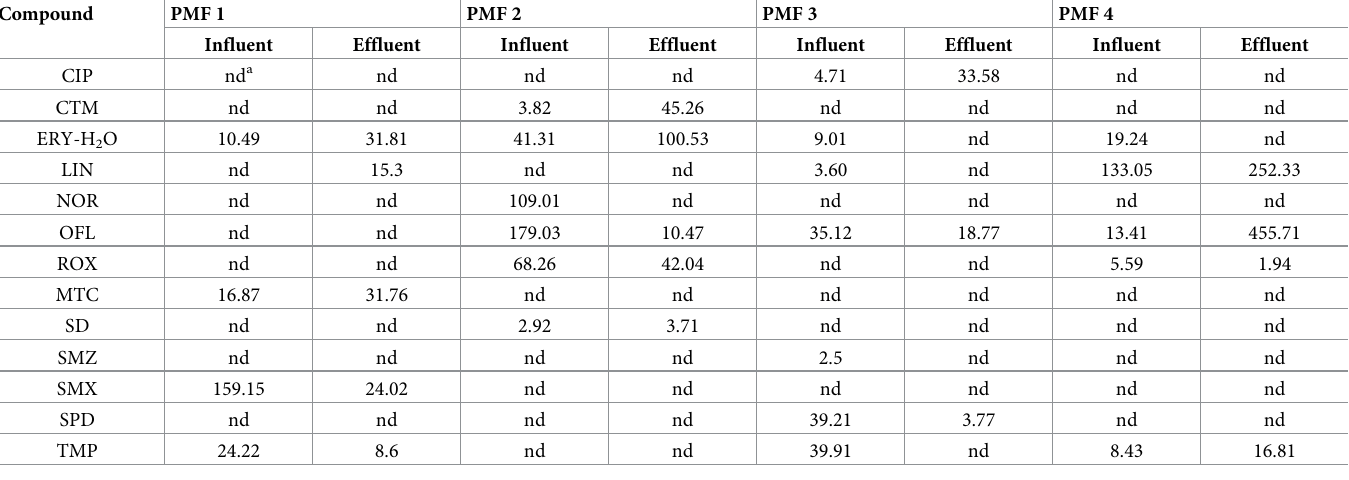
Table 1. Concentration (ng/L) and removal efficiency (%) of antibiotics in four PMFs samples (ng/L) (n = 16).